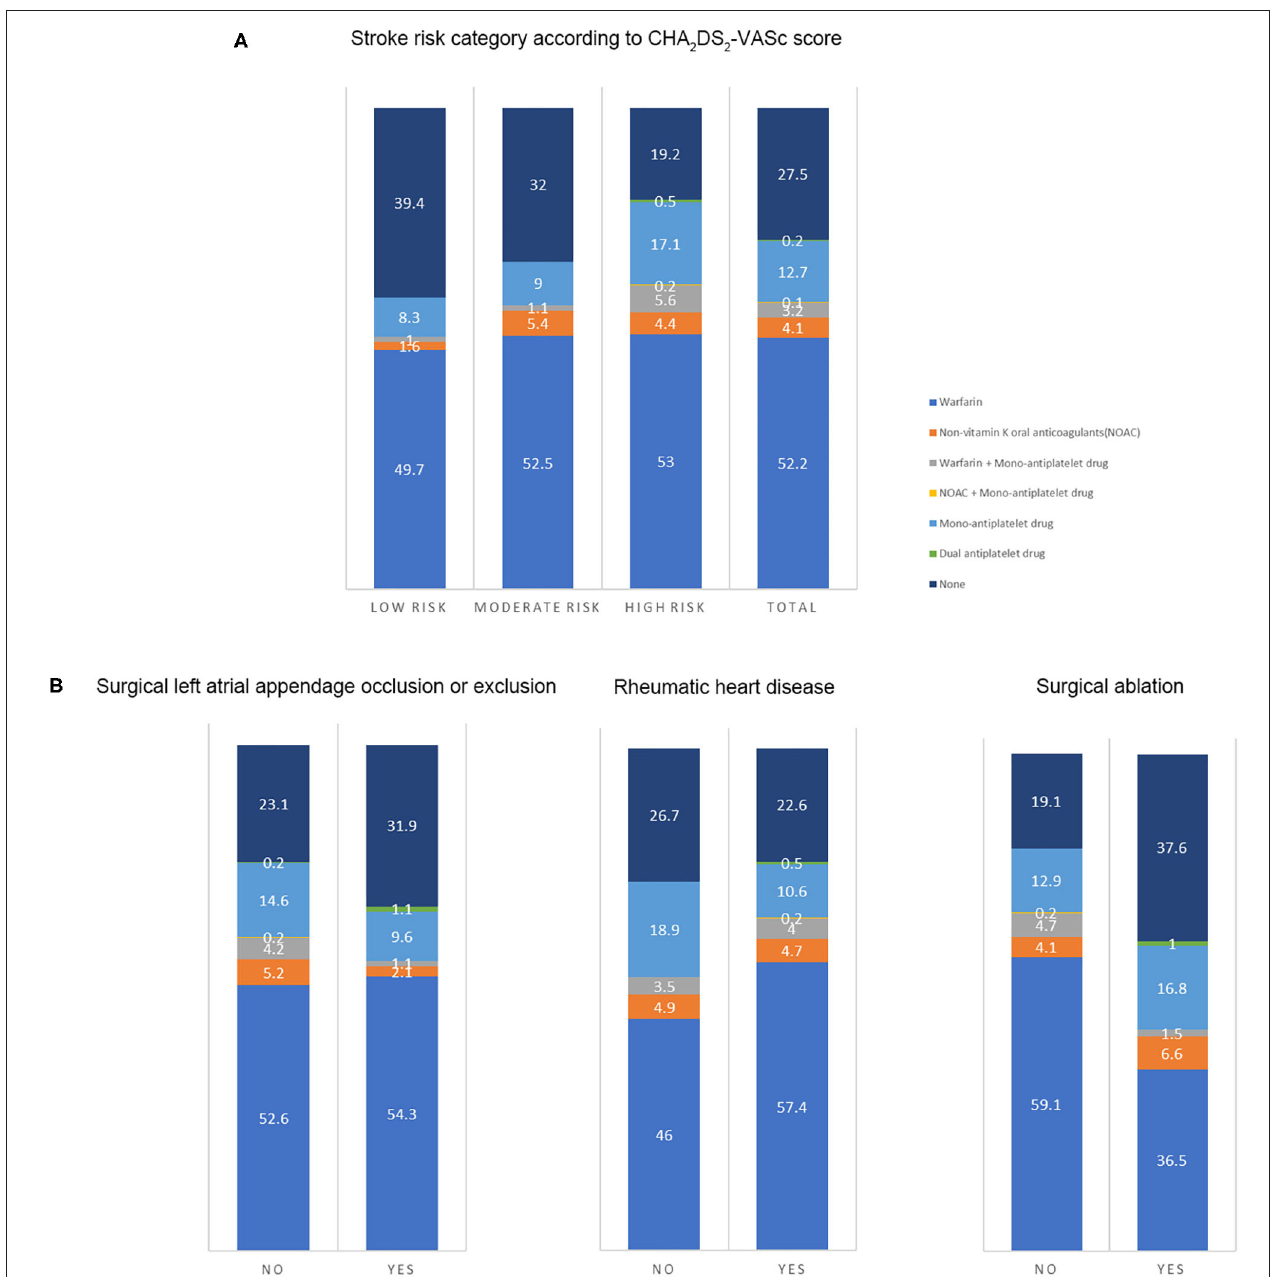
FIGURE 2 | The antithrombotic therapy in patients. The number on the figure was the percentage of therapies in each group. (A) Antithrombotic therapy in the total population and patients at different stroke risk ( n = 903) (Low risk: CHA 2 DS 2 -VASc score of 0 in male or 1 in female; intermediate risk: CHA 2 DS 2 -VASc score of 1 in male or 2 in female; high risk: CHA 2 DS 2 -VASc score ≥ 2 in male or 3 in female). (B) The antithrombotic agents in patients at moderate or high stroke risk in different groups ( n = 710) (With or without prior surgical left atrial appendage occlusion or exclusion; with or without a history of rheumatic heart disease; with or without a history of surgical